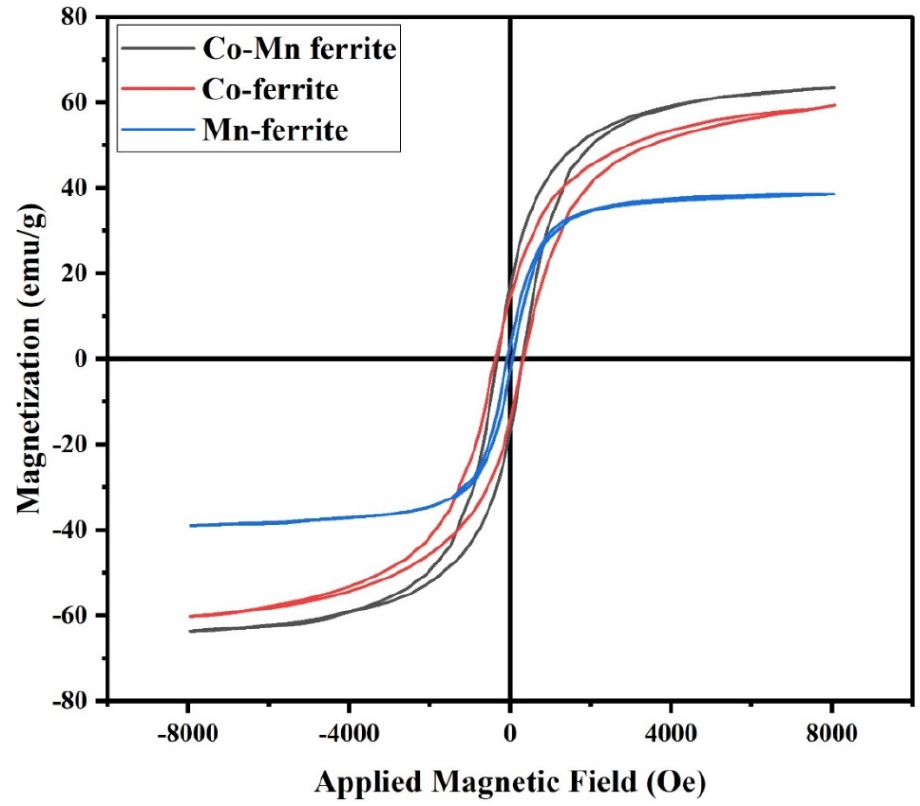
Figure 4. Magnetic hysteresis loops of the prepared ferrite samples.